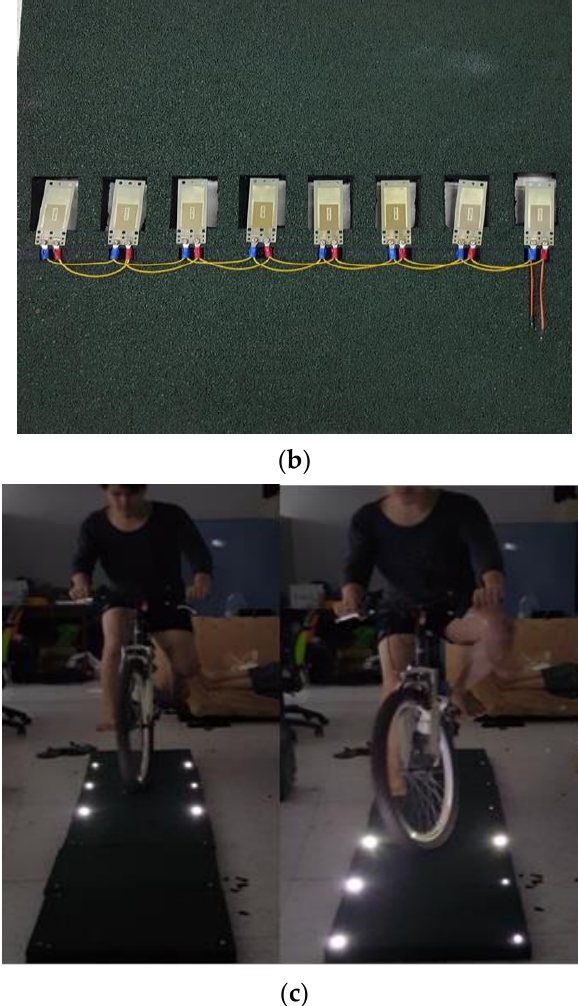
Figure 11. An overview of the power-generating bike lane demonstration section. ( a ) The overview of the 1.5 m pavement section. ( b ) An actual installation of piezoelectric plates. ( c ) Brightness of the lamps installed according to zoning.